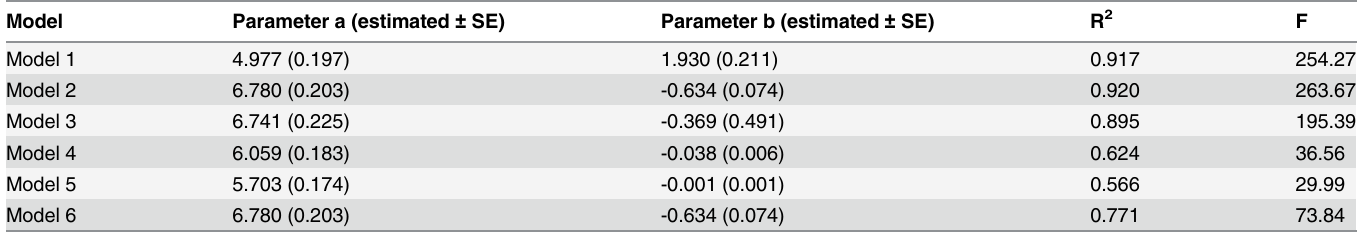
Table 3. Parameter estimates and coefficients of determination for six models tested and compared to parasitoid progeny recovered at six dis- tances after releases of Spalangia cameroni .